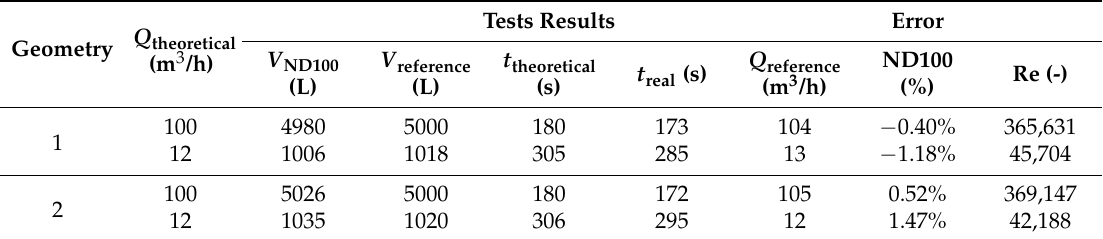
Table 1. Test results: experiments and relative errors achieved in section A, for different volume flow rates.